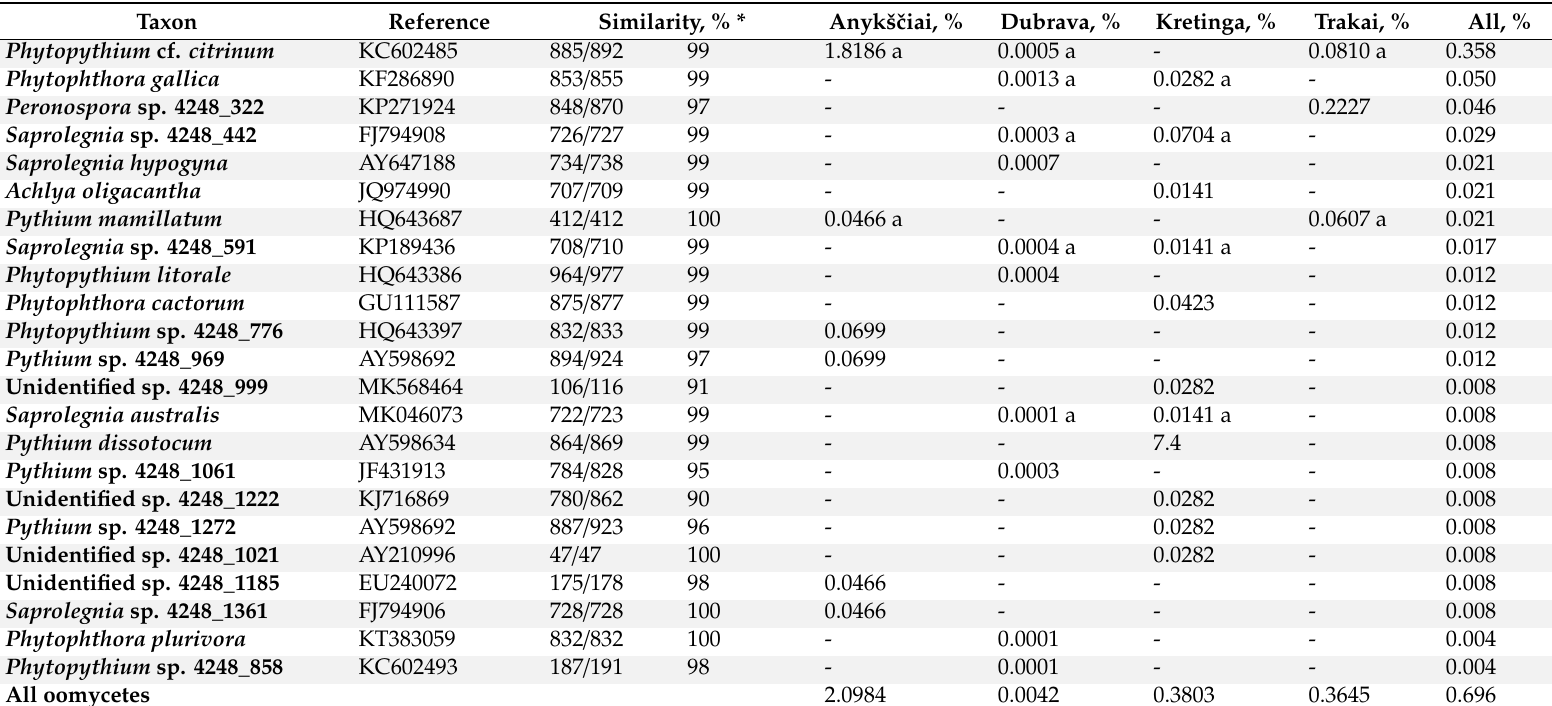
Table 4. Occurrence and relative abundance (shown as % of all high-quality fungal sequences) of oomycete taxa in irrigation water filtrate samples from Anykšˇciai, Dubrava, Kretinga and Trakai forest nurseries in Lithuania. Within each row, values followed by the same letter do not di ff er significantly at p >